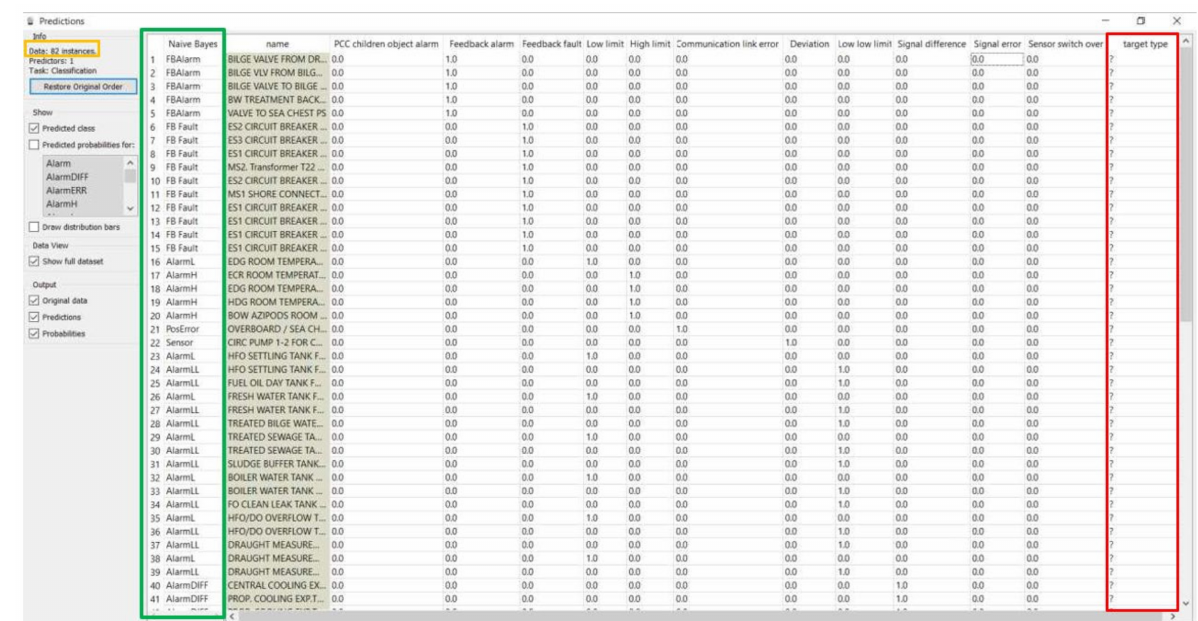
Figure 12. Screenshot of alarm data classification table using binary value instances.